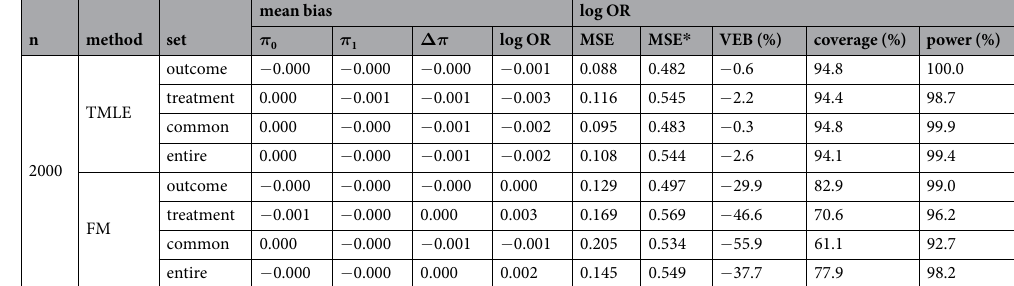
Table 2. Simulation results comparing the ATE estimation under the alternative hypothesis. * MSE in the presence of an unmeasured confounder. Theoretical values: π π θ = . = . = . 0 557, 0 441,